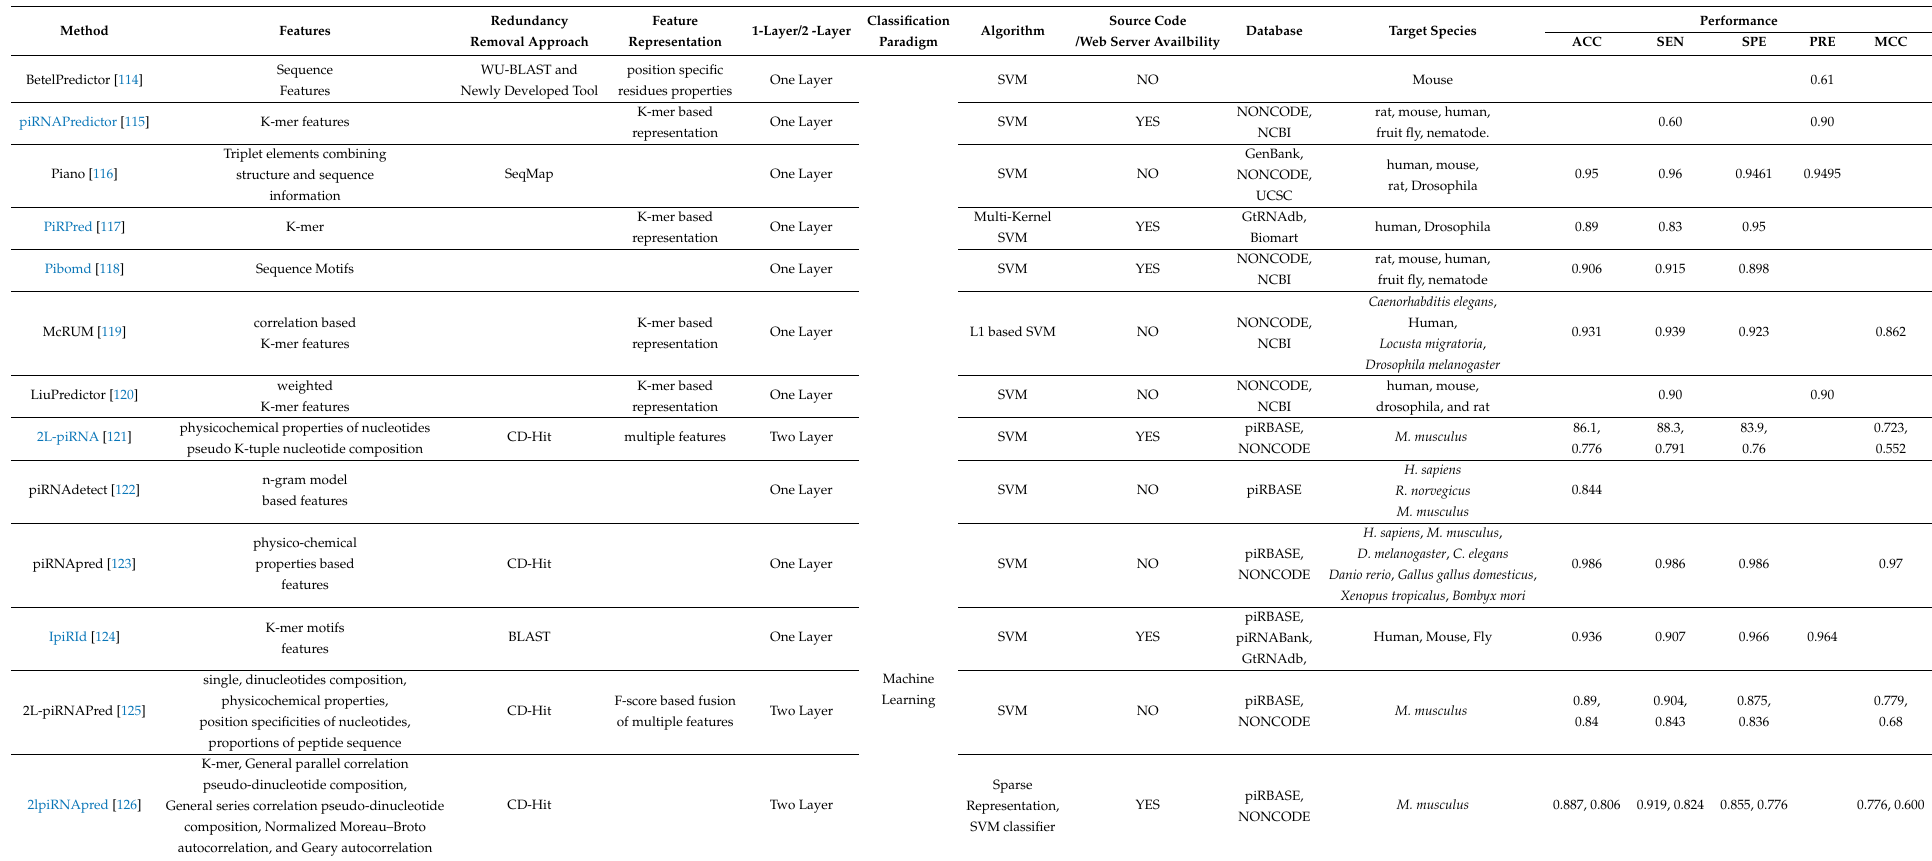
Table 4. A broad classification of computational approaches proposed to identify piRNA